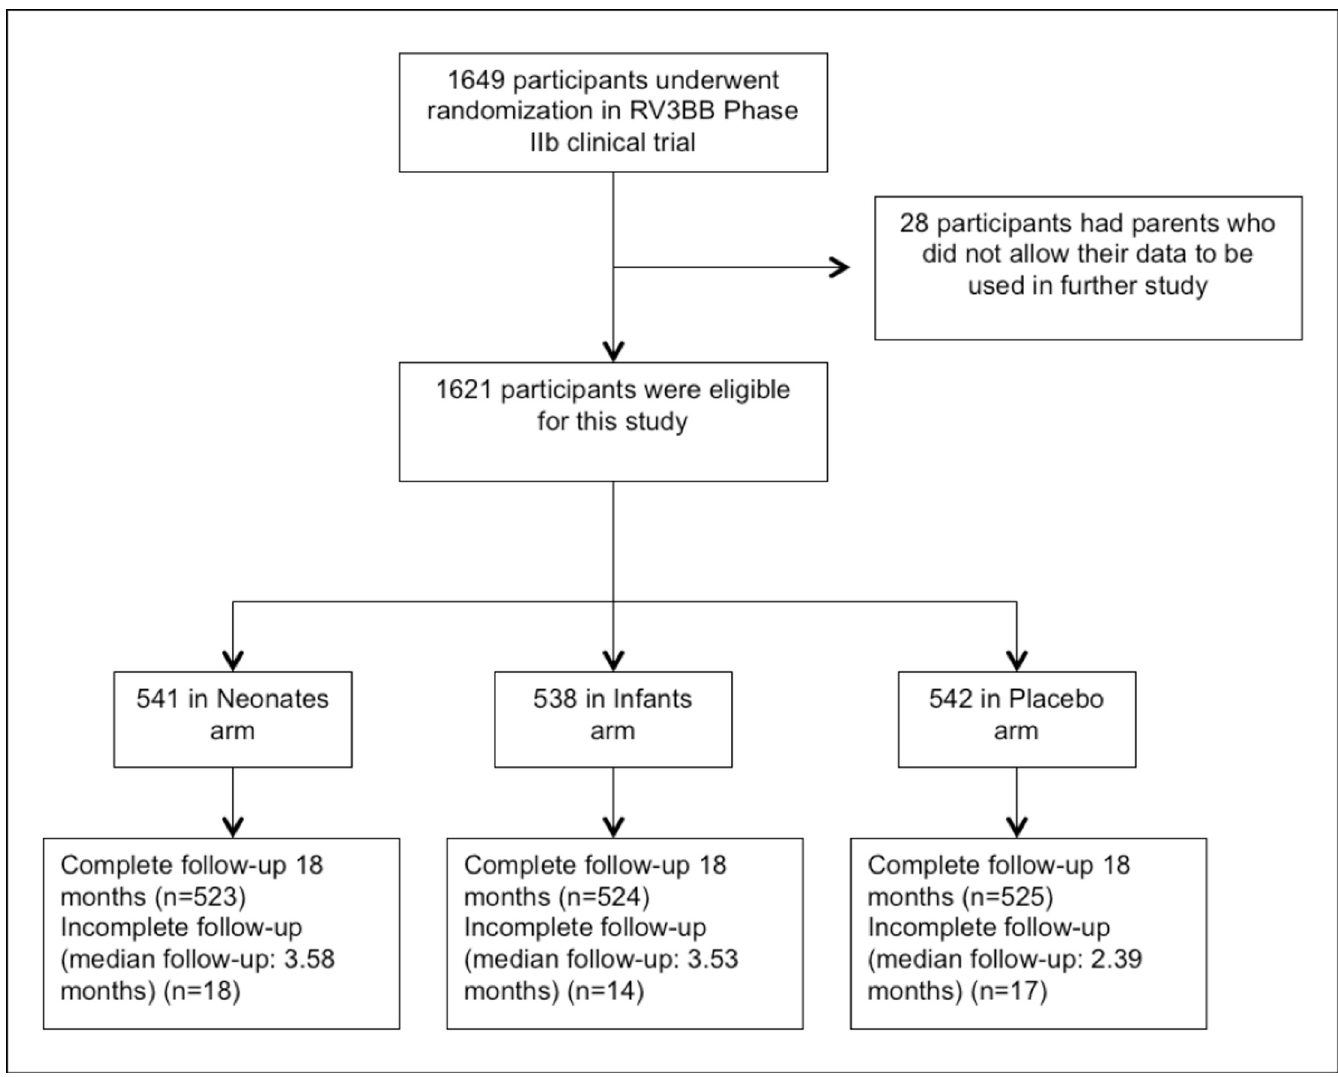
Fig 1. Flow diagram of participants